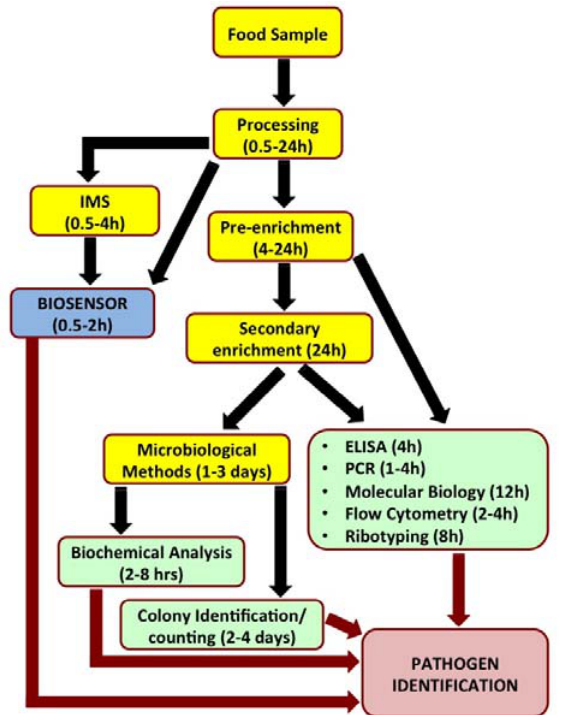
Figure 1. A flowchart elucidating the processing steps involved and relative time taken in detecting a pathogen in a food sample. IMS stands for immune-magnetic separation where particles with magnetic properties are modified with target-specific antibody/antibody fragments for capture and subsequent purification using external magnetic